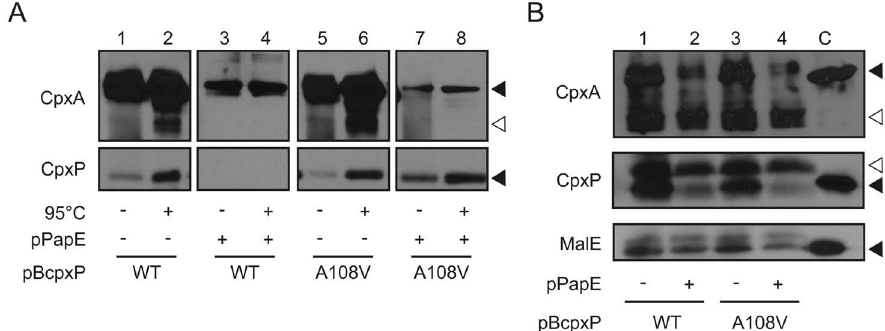
The mechanistic details of signal integration by two-component systems (TCSs) remain incomprehensible. Especially the function of accessory proteins that act as co-sensors is largely unknown.